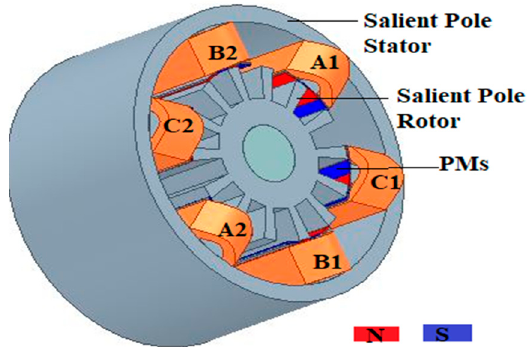
Figure 7. A typical 3D Structural view of 6/14 inner pole rotor of FRM [24].